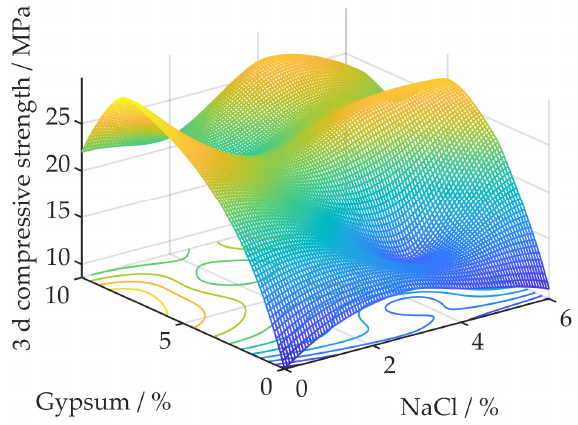
Figure 7. 3-day compressive strength of concrete.